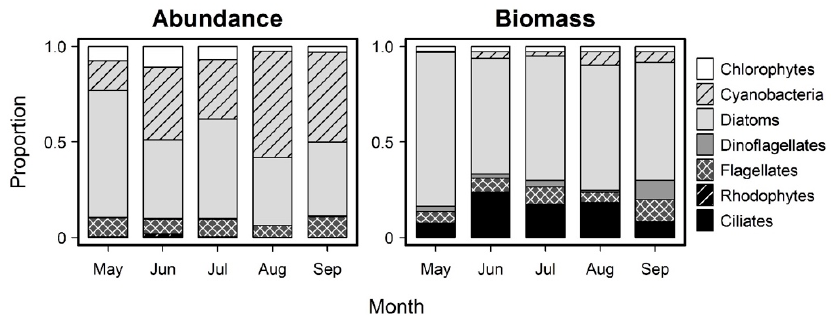
Figure 2. Proportional abundance ( left ) and proportional biomass ( right ) of ambient microplankton taxa for Day 0 initial control samples.